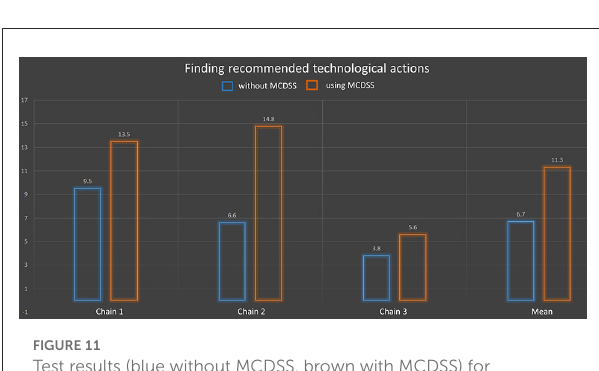
FIGURE10 Protocol designed to assess the impact of MCDSS use in the reasoning task.